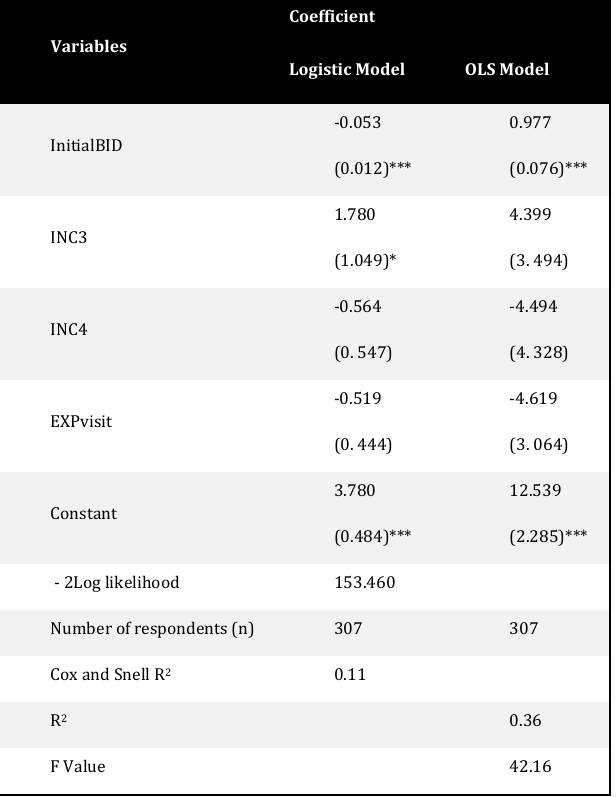
Table 2: CVM analysis result